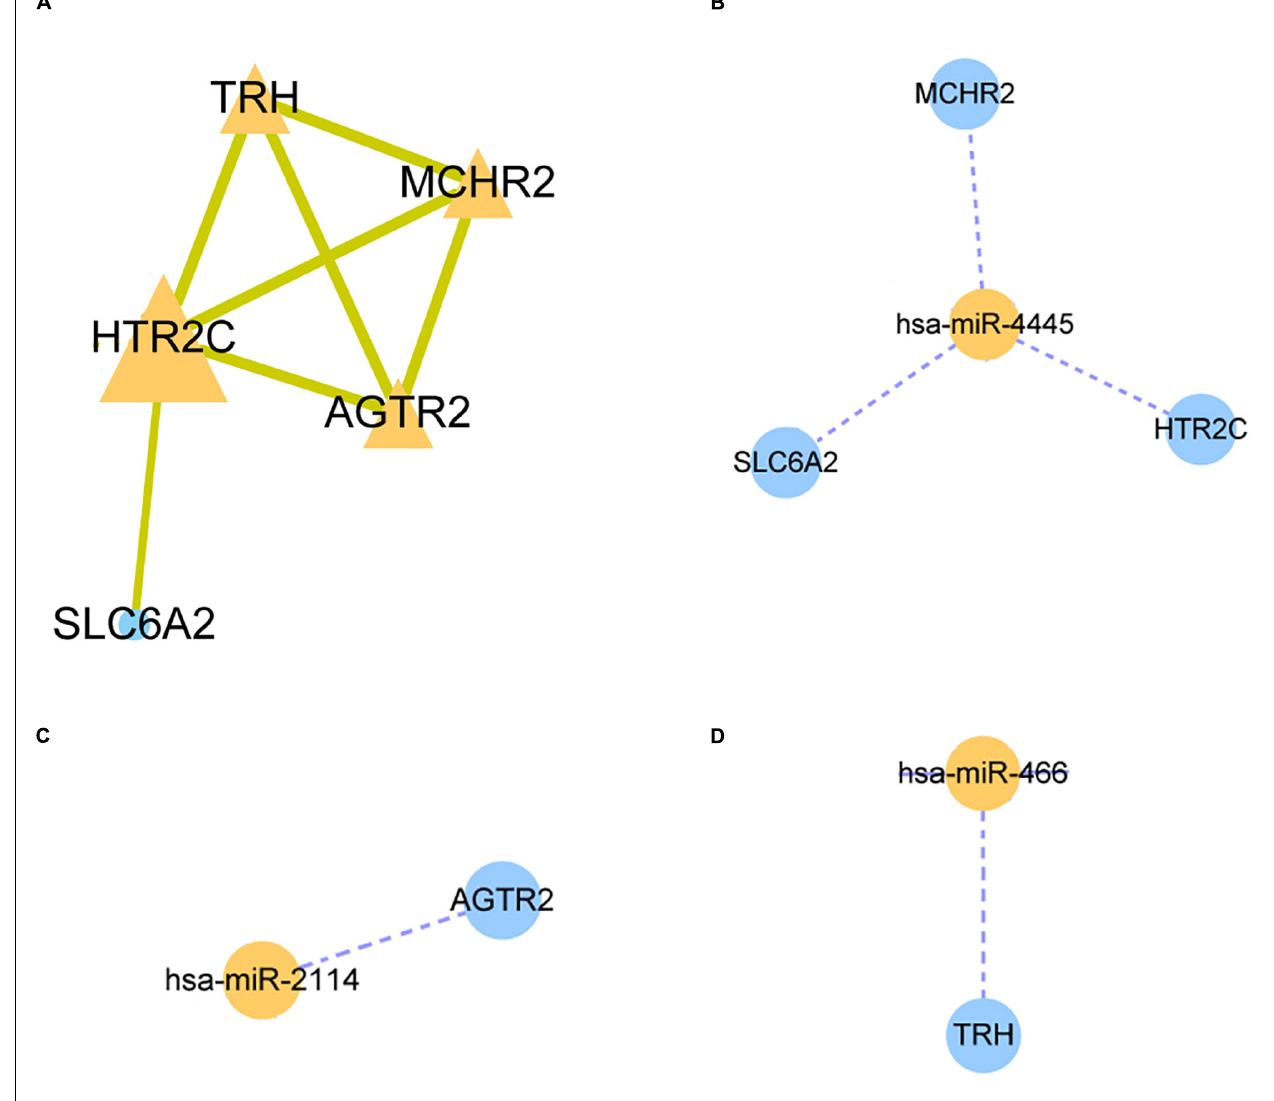
FIGURE 3 | Protein-protein interaction (PPI) network and miRNA-mRNA regulatory network construction. (A) The PPI nework for HTR2C. (B–D) The miRNA-mRNA regulatory network for hsa-miR-4445, hsa-miR-2114, hsa-miR-466 respectively.